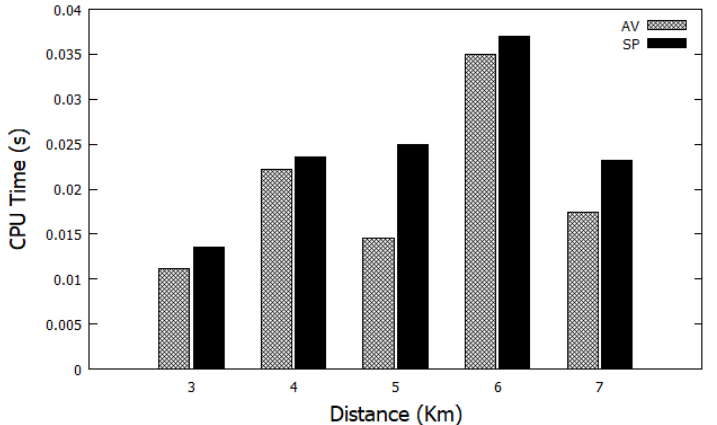
Figure 4. Comparison of CPU time between AV and SP using different